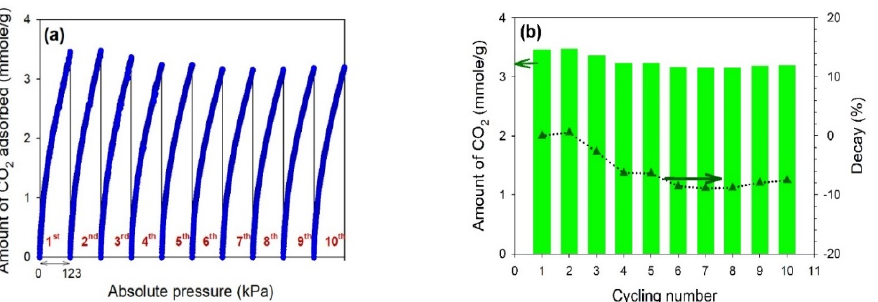
Figure 9. ( a ) Successive 10 cyclic adsorption tests and ( b ) the variation in the CO 2 adsorption capacities at 123 kPa.